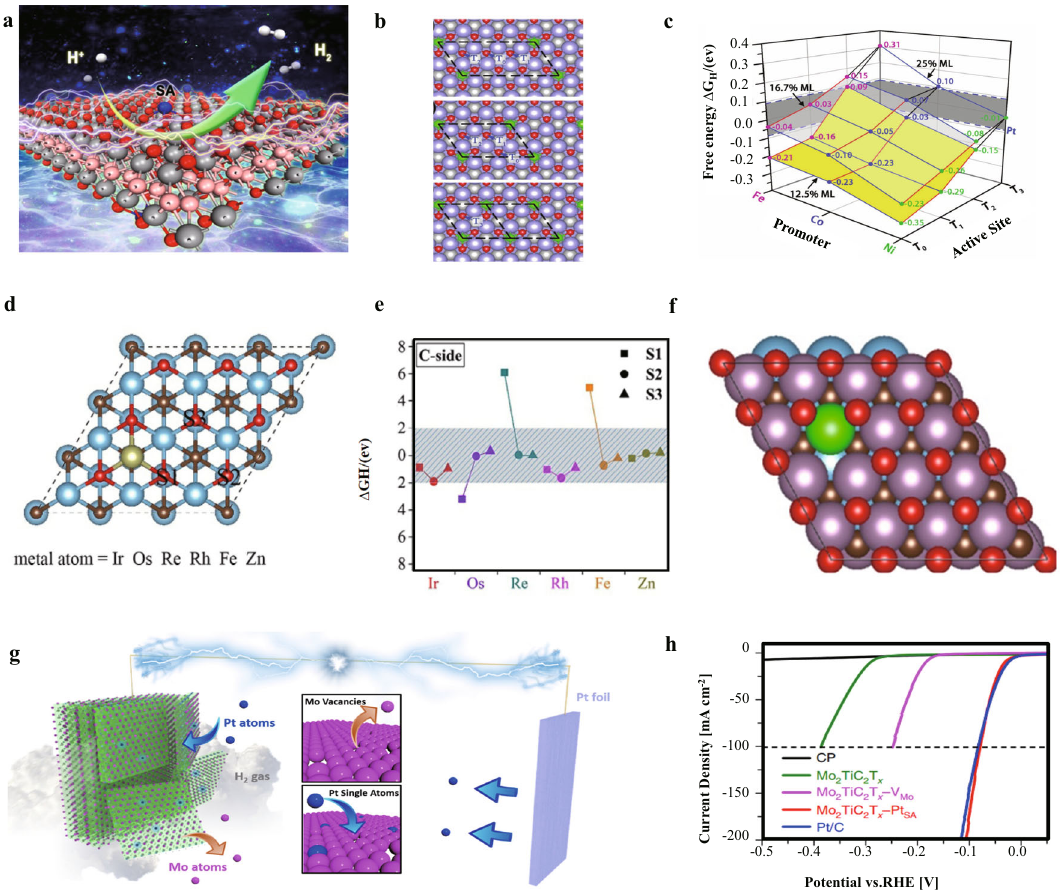
Fig. 8 MXenes-based HER electrocatalysts optimized by metal-atom doping. a Schematic illustration of hydrogen evolution of TM-doped MXenes. b The structural and computational models of TM-promoted V 2 CO 2 . c Calculated Δ G H of V 2 CO 2 with 12.5%, 16.7%, and 25% monolayer (ML) H coverage on one surface TM coverage as a function of promoter and active site 84 . Copyright 2016, WILEY-VCH. d Top and side view of metal modi fi ed Ti 3 CNO 2 MXenes. S 1 , S 2 and S 3 denote the sites for H atom adsorption sites. e Calculated Δ G H on C-side of